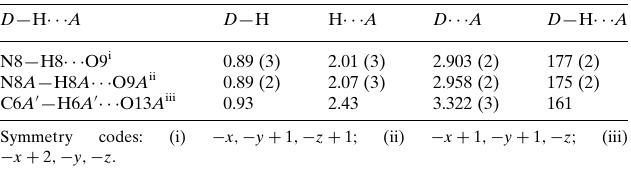
Hydrogen-bond geometry (A˚ , (cid:3)